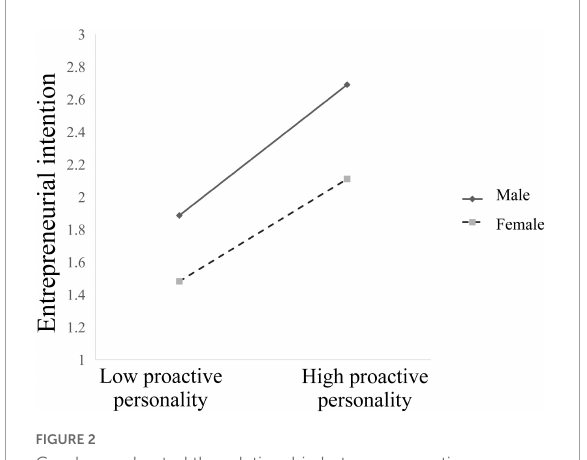
FIGURE2 Gender moderated the relationship between proactive personality and entrepreneurial intention.